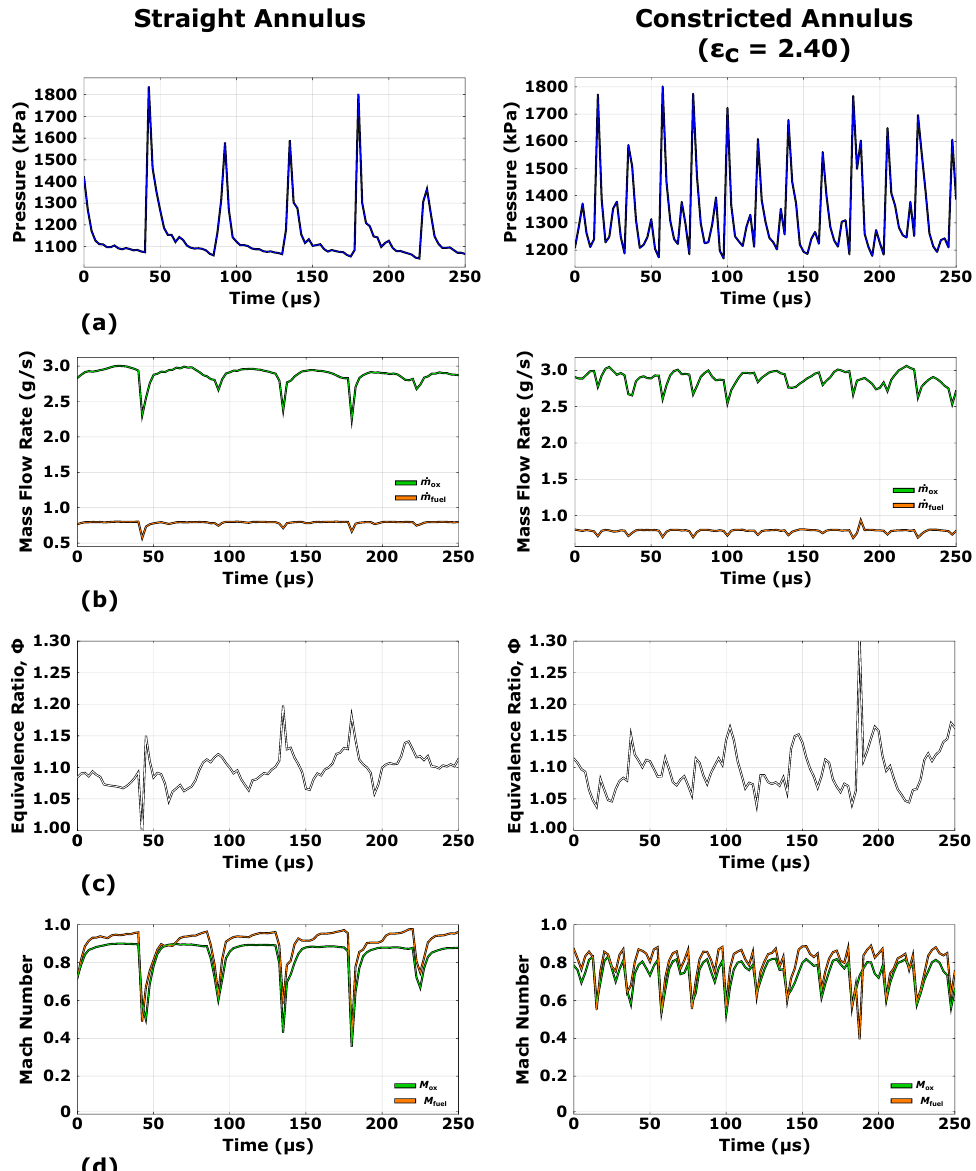
Figure 24. Injection recovery results from high-fidelity simulations for the straight (left) and (cid:101) c = 2.40 constricted annuls (right), showing the oscillatory ( a ) detonation pressure, ( b ) injection mass flow rate, ( c ) local equivalence ratio, and ( d ) injection Mach